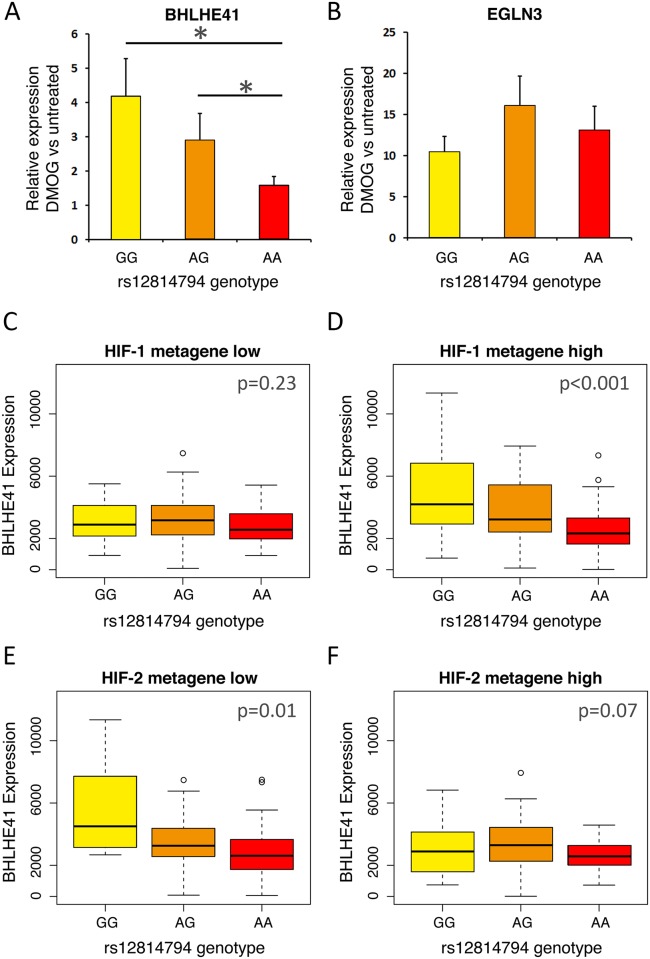
Interaction between HIF level, rs12814794 genotype and expression of BHLHE41 mRNA.A) 33 genotyped primary tubular cell cultures (3 GG, 12 AG, and 18 AA) were exposed to 1 mM DMOG to induce HIF. BHLHE41 mRNA expression was assayed by qPCR. The mean (± standard deviation) inducibility of BHLHE41 mRNA compared to the respective untreated cells (= 1) was then plotted for each of the different rs12814794 genotypes. *, p<0.05—Student’s t-test. B) The mean inducibility of EGLN3 mRNA levels in the same samples was plotted as control. C-F) Box-and-whisker plots showing the correlation between BHLHE41 mRNA levels and genotype at rs12814794 in TCGA analysis of ccRCC tumors (KIRC). Tumors were first divided into tertiles according to expression of previously described HIF-1 or HIF-2 metagenes C) lower tertile for HIF-1 metagene expression, D) upper tertile for HIF-1 metagene expression, E) lower tertile for HIF-2 metagene expression, F) upper tertile for HIF-2 metagene expression. χ2-test was used to calculate p values for higher expression in GG individuals compared to AA individuals. Whiskers extend to 1.5 times of the inter quartile range.